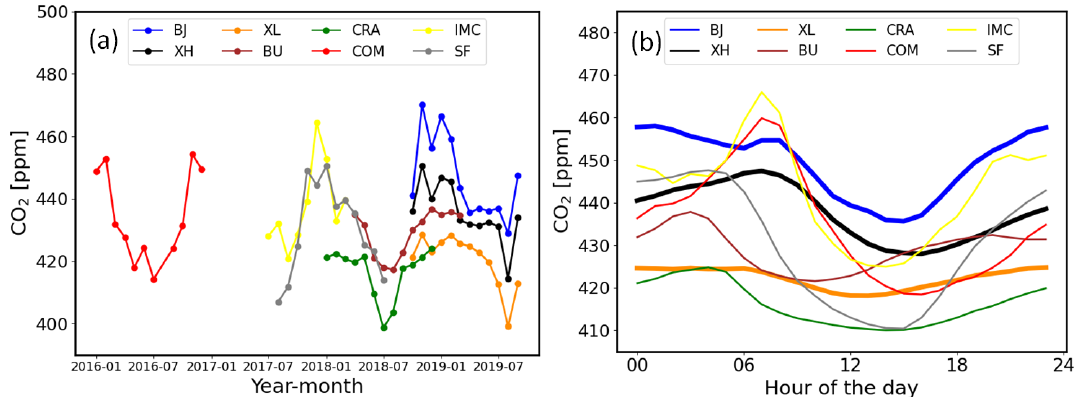
Figure 5. (a) Monthly means of CO 2 at BJ (L1), XH (L1), and XL between October 2018 and September 2019 and at BU, CRA, COM, IMC, and SF during the latest 1 year and (b) the diurnal cycles of CO 2 .